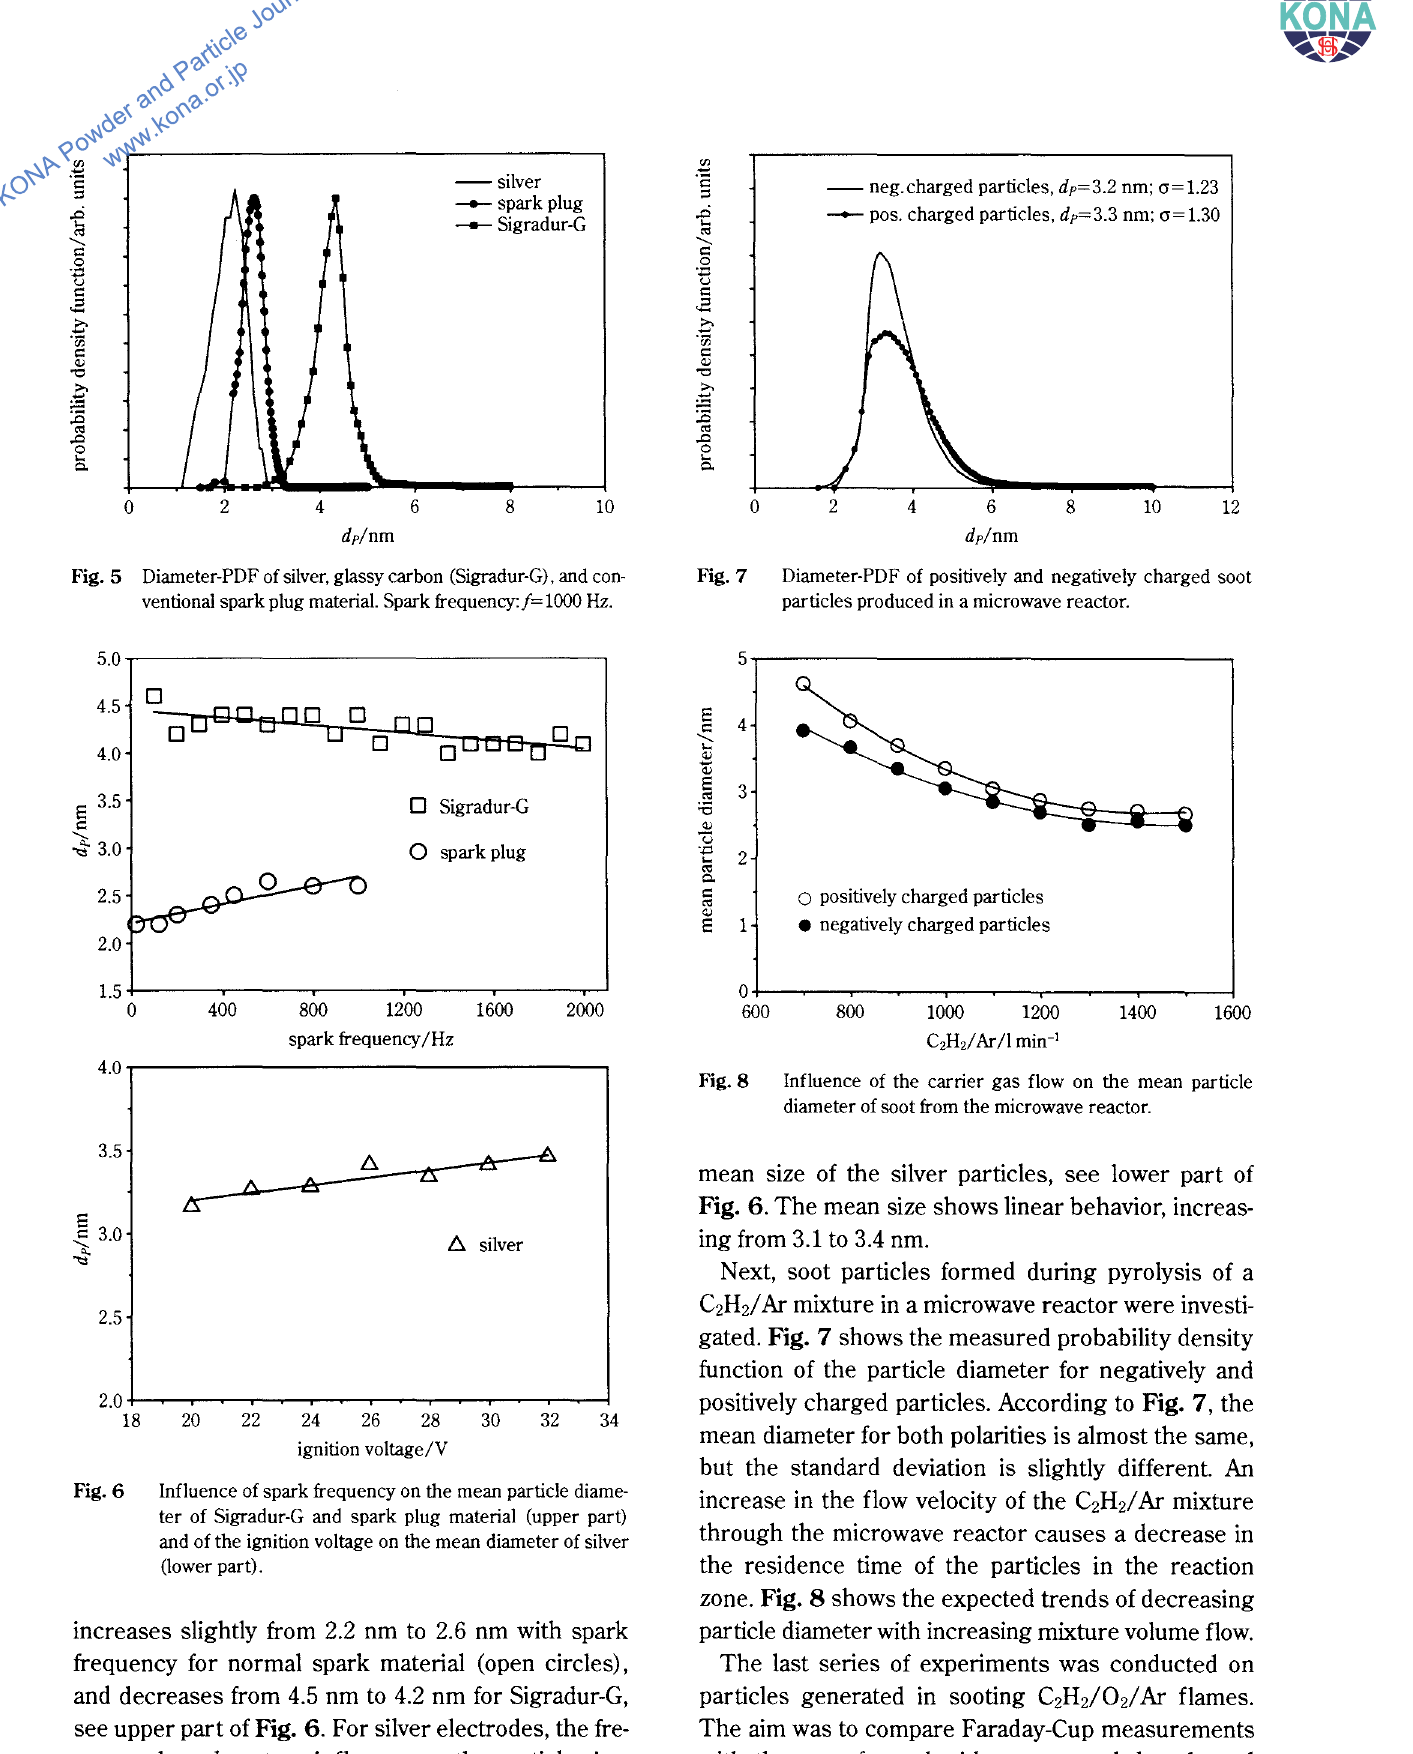
zone. Fig. 8 shows the expected trends of decreasing particle diameter with increasing mixture volume